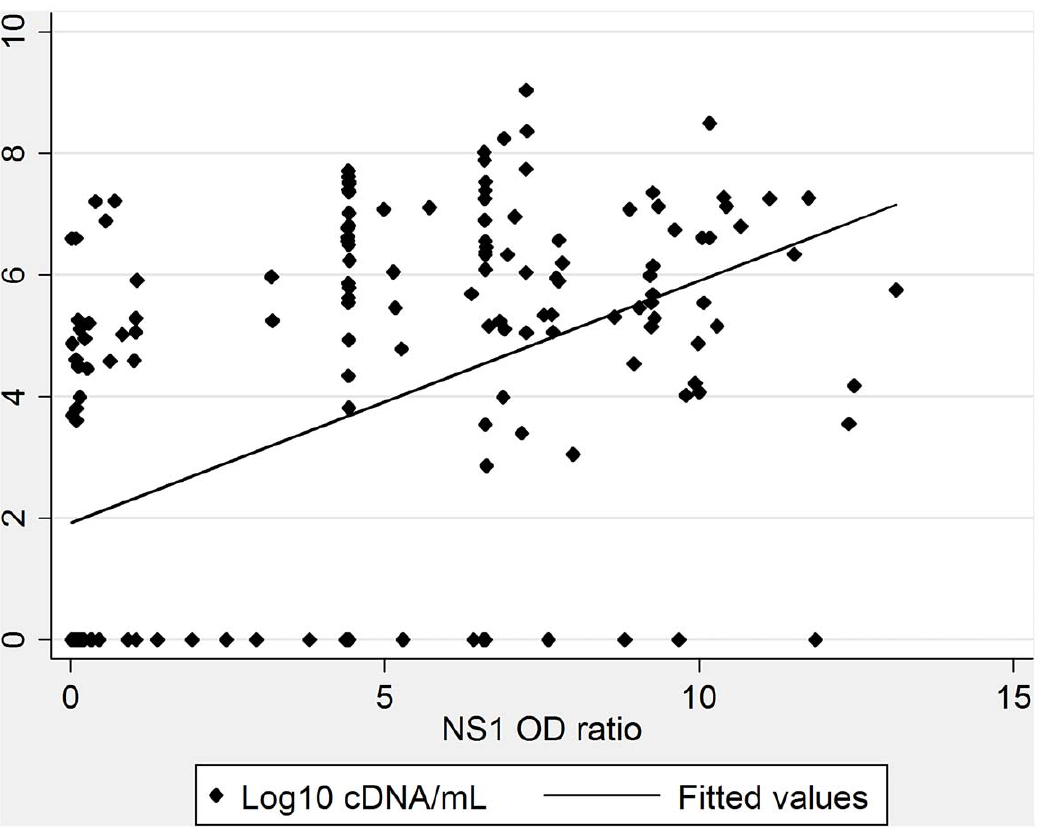
Figure 2. Comparison of NS1 antigen OD* ratio and viral load (log 10 cDNA equivalents/mL). *OD: optical density.